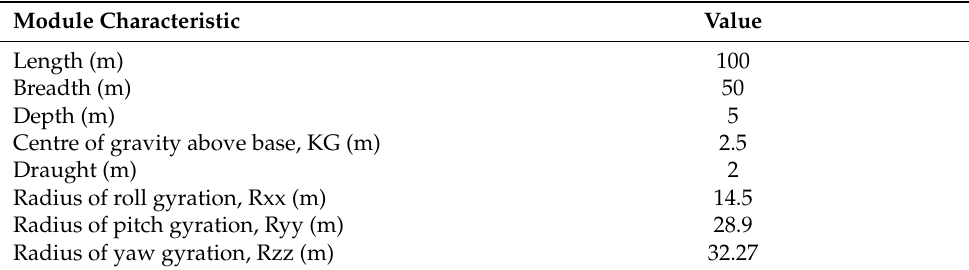
Table 1. Parameters of single module.